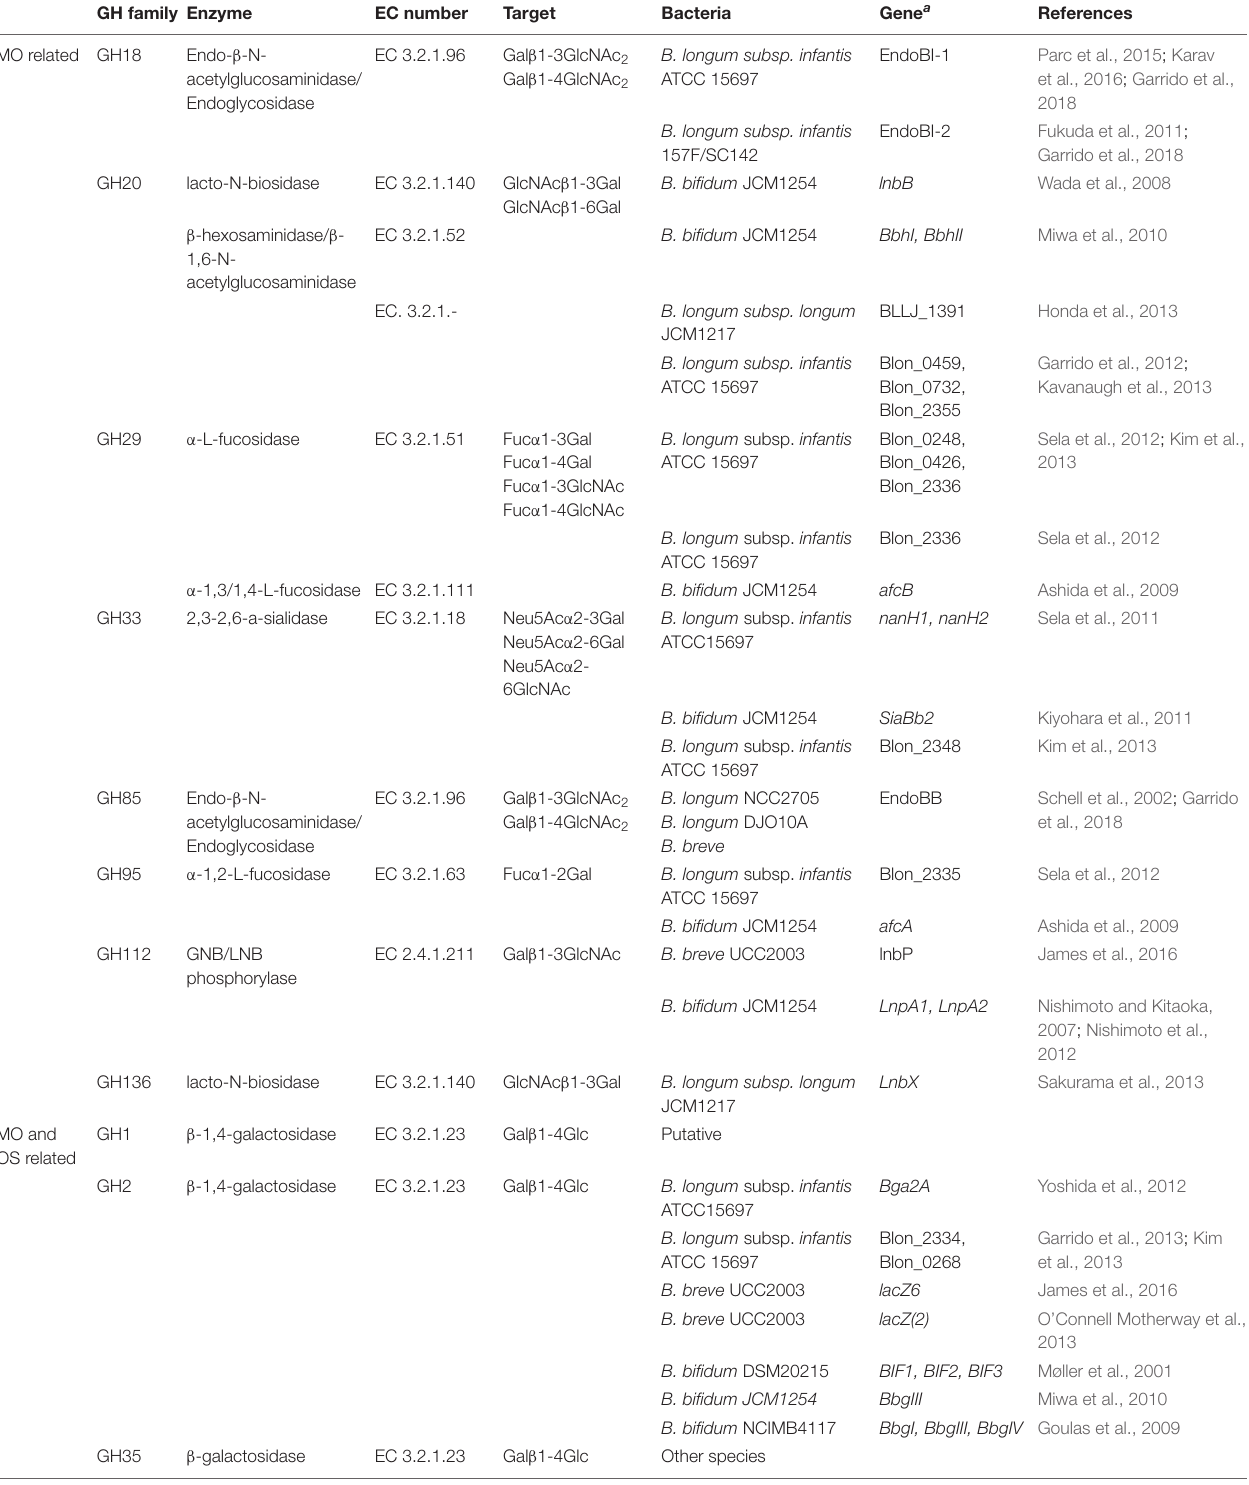
TABLE 1 | GH families of the infant gut microbiota and their identified specific enzymes that have been found to take part in HMO, GOS and FOS degradation. Enzymes are associated with their target and the bacteria from which they have been isolated. GH family Enzyme EC number Target Bacteria Gene